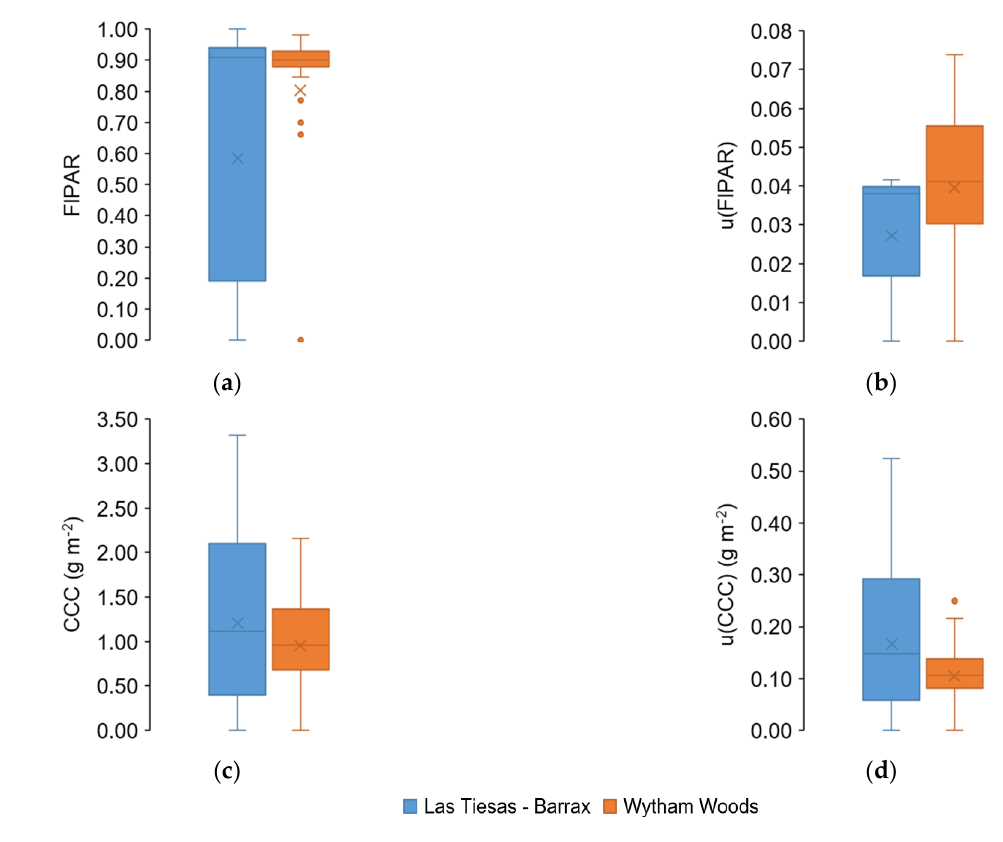
Figure 7. Box plots of in situ FIPAR and CCC reference measurements ( a , c ) and their associated expanded uncertainties at the k = 2 coverage interval ( b , d ).